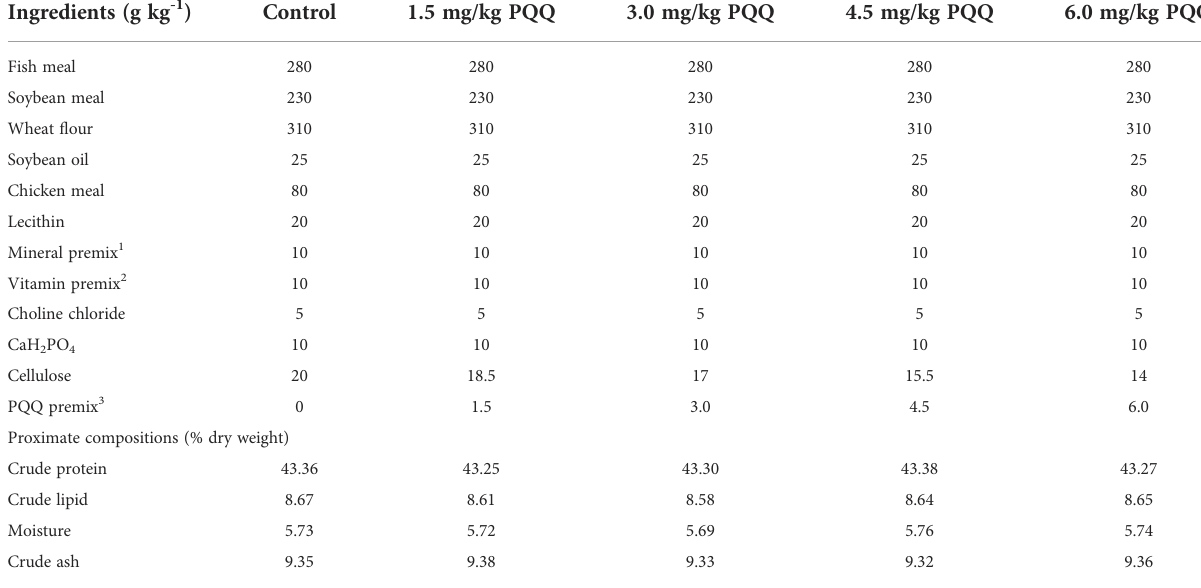
TABLE 1 Diet formulation and proximate